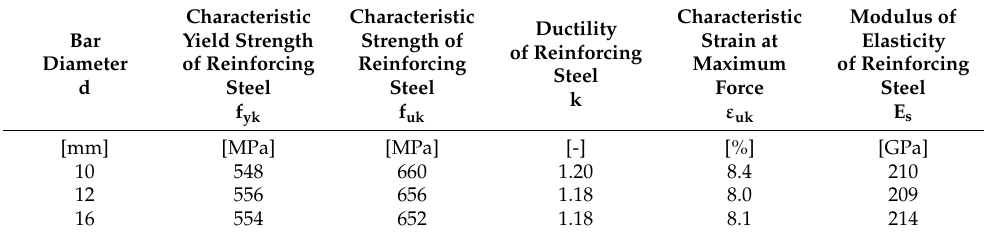
Table 5. Test results of selected strength parameters of reinforcing steel.